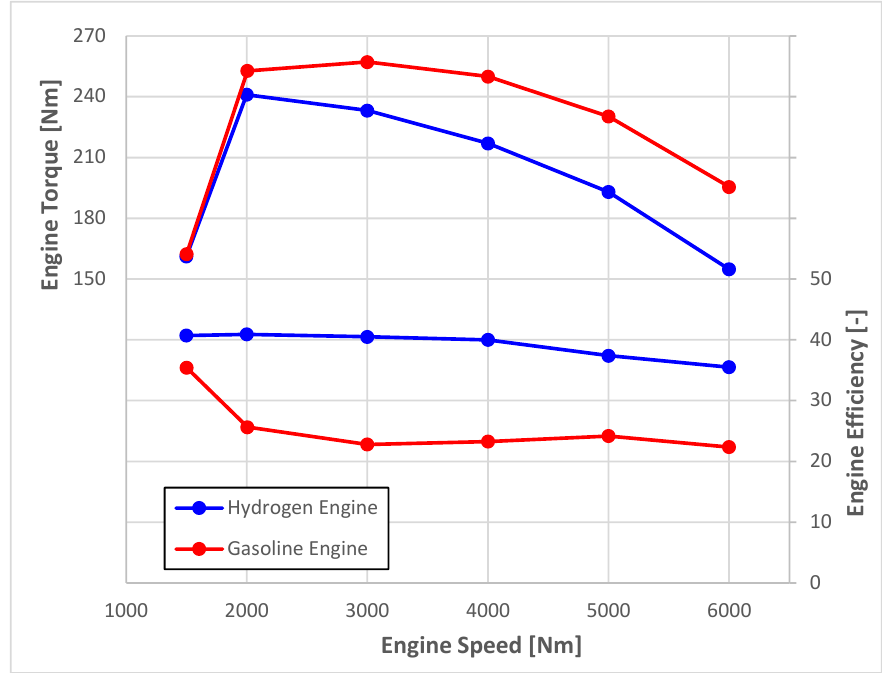
Figure 9. Torque and efficiency at full load. Comparison between the engines running with hydrogen and gasoline.